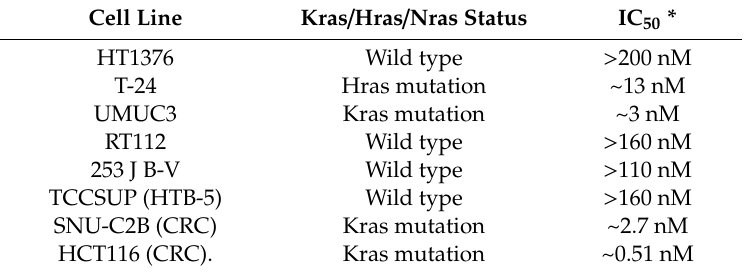
Table 1. Relative IC50 comparison among the bladder cancer cell lines used in the